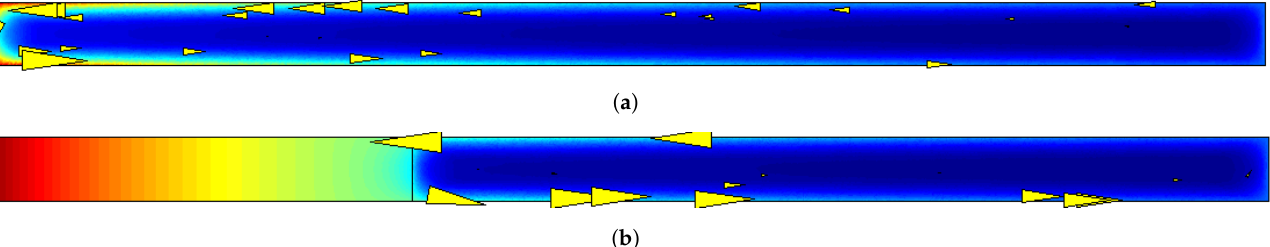
Figure 4. Magnitude of H ϕ (color) and eddy current density (arrows) in the tank wall. ( a ) Case c = a . ( b ) Case c − a = 85.0mm.